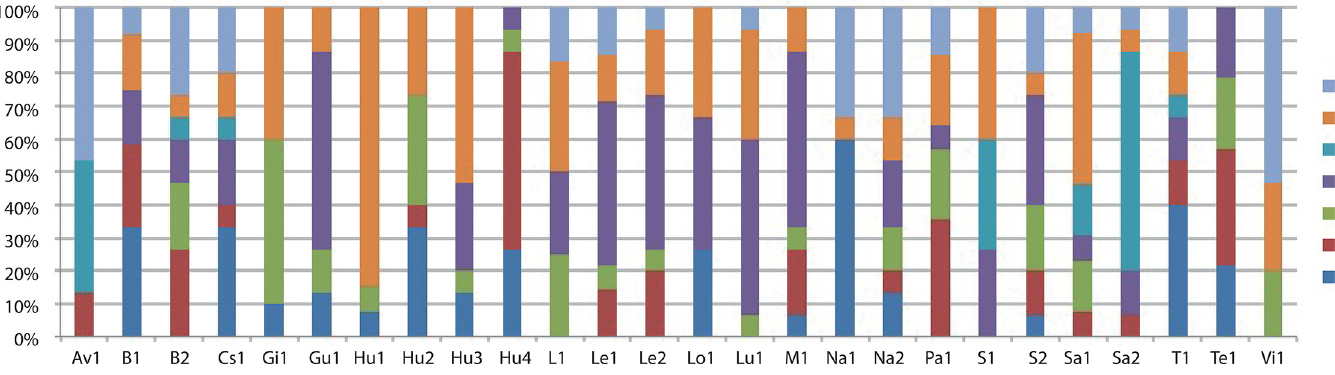
Fig 6. Percentage of individuals that belong to each of the seven genetic clusters (represented by different colours) inferred by the nonhierarchical K-means clustering analysis [46]. Each vertical column corresponds to a population. See Table 1 for population codes.